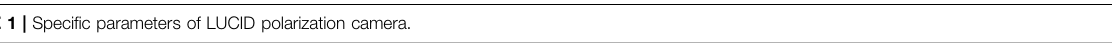
TABLE 1 | Speci fi c parameters of LUCID polarization camera.